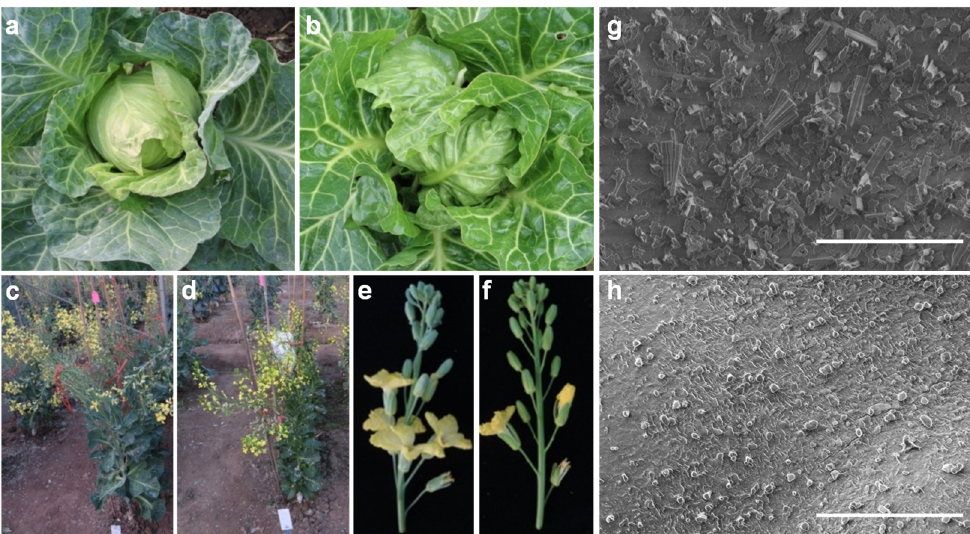
Figure 1. Phenotypes of wild-type and nwgl plants. The leaf appearance of wild-type ( a ) and nwgl plants ( b ) at the head harvesting stage. Wild-type ( c ) and nwgl ( d ) plants at the flowering stage. ( e ) Wild-type flowers. ( f ) nwgl flowers. Cuticular wax crystals formed on adaxial surface of the wild-type ( g ) and nwgl ( h ) leaf blades visualized by cryo-scanning electron microscopy. Bar = 10 µ m in ( g ) and ( h ).